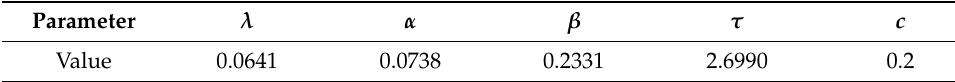
Table 1. The results of parameter calibration.